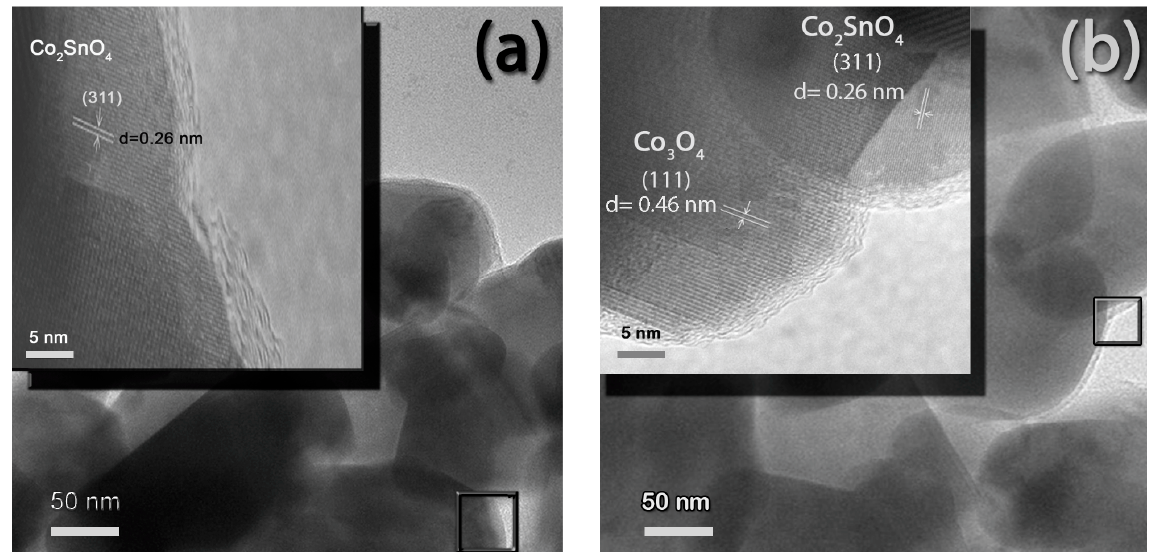
Figure 4. TEM images of pure Co 2 SnO 4 ( a ) and Co 2 SnO 4 /Co 3 O 4 composite ( b ).